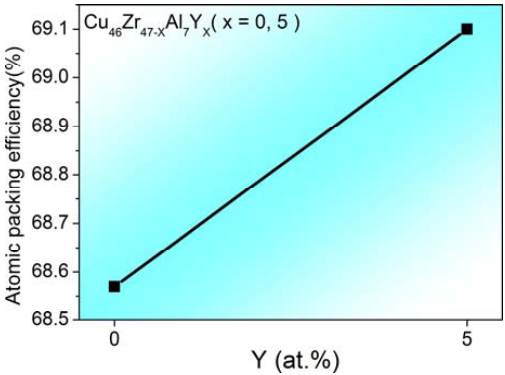
Figure 4. Atomic packing efficiency values of Cu 46 Zr 42 Al 7 Y 5 and Cu 46 Zr 47 Al 7 samples.